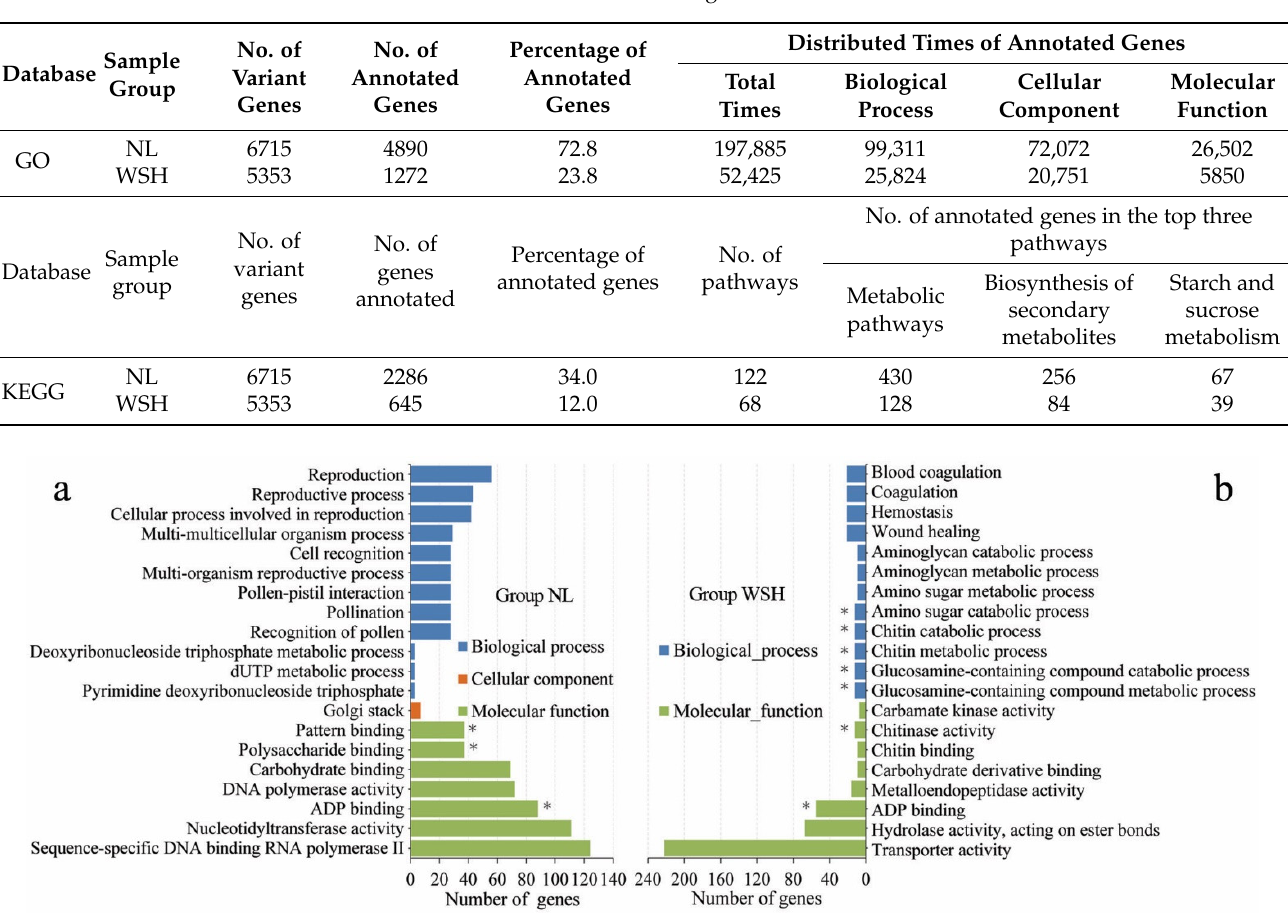
Table 1. Annotation and distribution of variant genes in GO and KEGG databases.